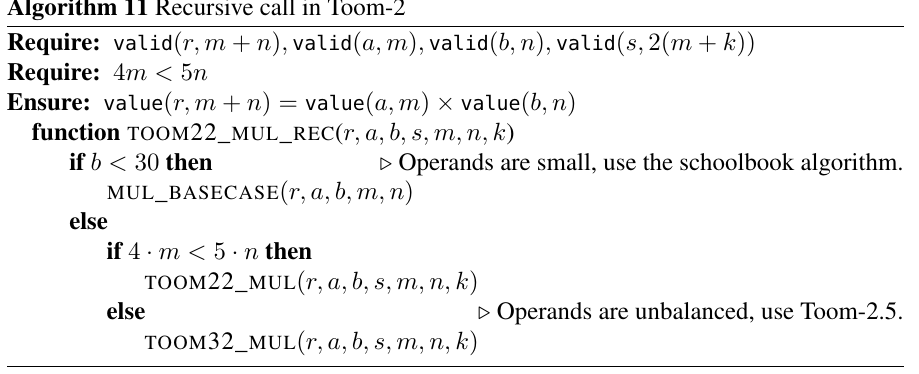
Algorithm 11 Recursive call in Toom-2